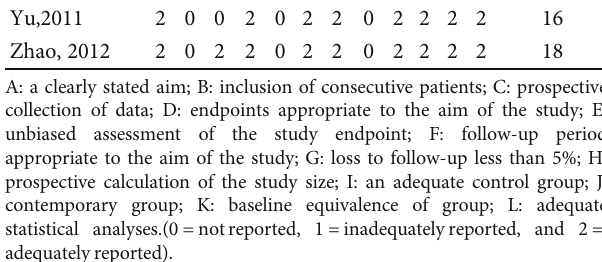
A: a clearly stated aim; B: inclusion of consecutive patients; C: prospective collection of data; D: endpoints appropriate to the aim of the study; E: unbiased assessment of the study endpoint; F: follow-up period appropriate to the aim of the study; G: loss to follow-up less than 5%; H: prospective calculation of the study size; I: an adequate control group; J: contemporary group; K: baseline equivalence of group; L: adequate statistical analyses.( 0 = notreported , 1 = inadequatelyreported , and 2 = adequatelyreported